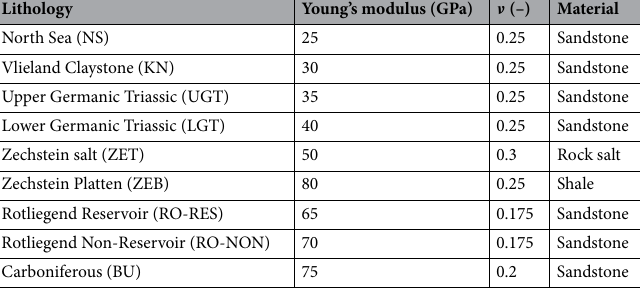
Table 4. Lithological properties in the Bergermeer field 89,90 .